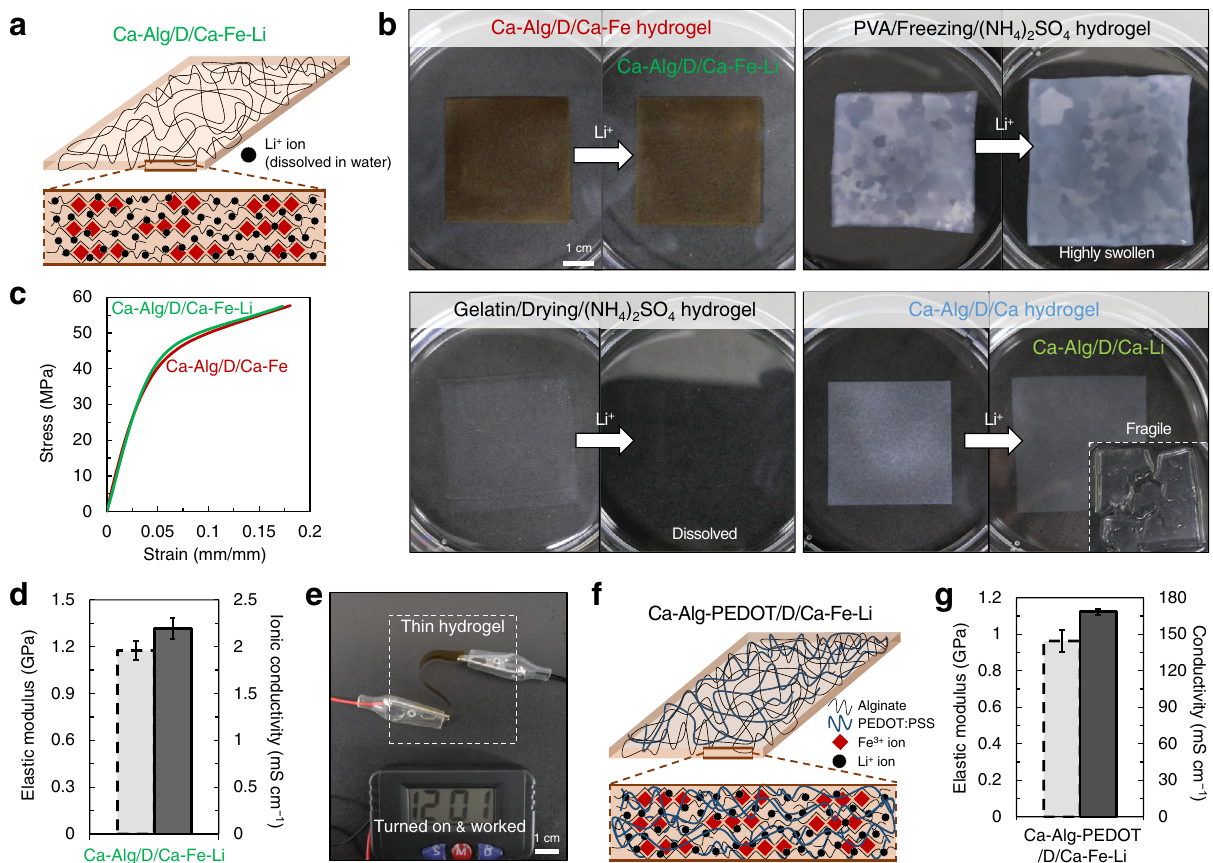
Fig. 4 Mechanically robust, conductive hydrogels applicable as a gel electrolyte. a Illustration of Ca – Alg/D/Ca – Fe – Li hydrogel for electrolyte. b Photograph showing the fabrication of Ca – Alg/D/Ca – Fe – Li hydrogel and its stability in Li + solution, and low mechanical stability of other hydrogels (PVA, gelatin, and Ca – Alg/D/Ca) in Li + solution. c Stress – strain curves for Ca – Alg/D/Ca – Fe hydrogel before and after being soaked in Li + solution. d Elastic modulus and ionic conductivity of Ca – Alg/D/Ca – Fe – Li hydrogel. e Photograph showing stable working performance of the Ca – Alg/D/Ca – Fe – Li hydrogel as a solid gel electrolyte. f Illustration of PEDOT-contained reconstructed hydrogel, Ca – Alg-PEDOT/D/Ca – Fe – Li. g Elastic modulus and conductivity of Ca – Alg-PEDOT/D/Ca – Fe – Li hydrogel. Error bars correspond to standard